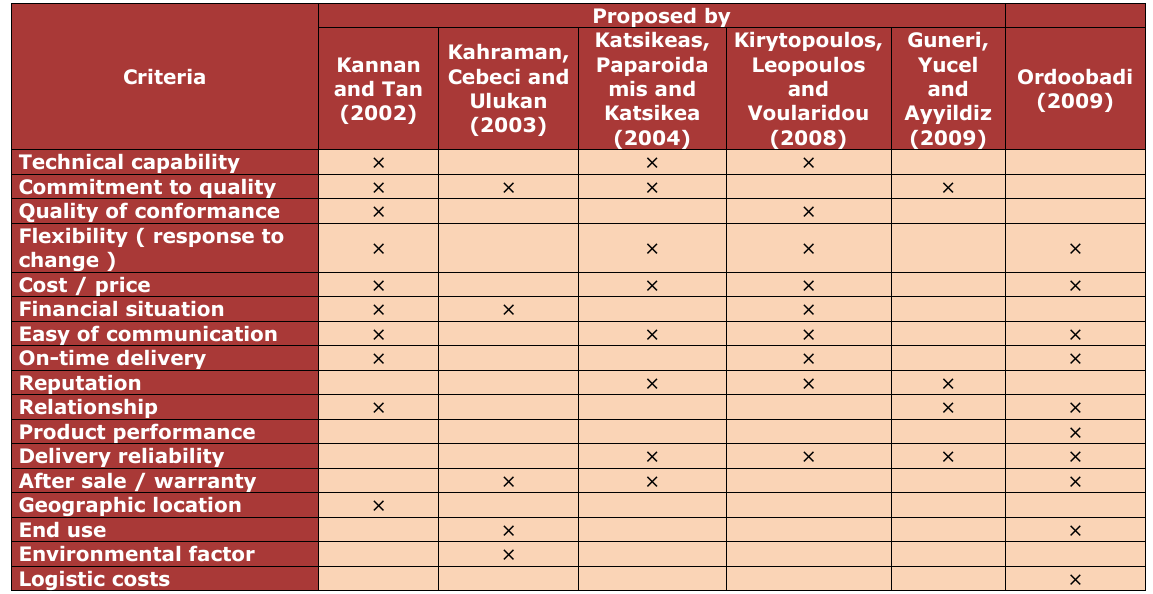
Table 1. Supplier performance criteria according to selected